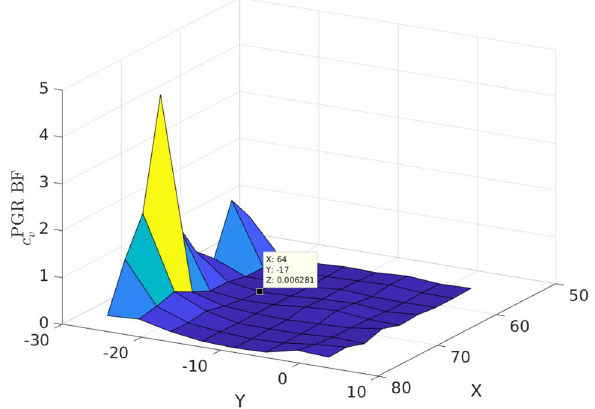
Fig. 12 c PGR v index for each (X,Y) sphere’s position